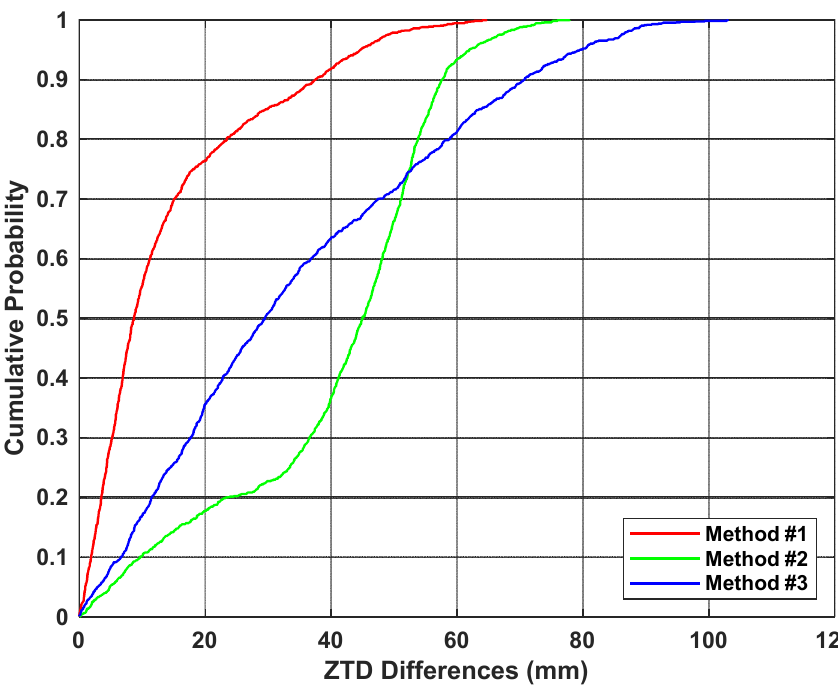
Figure 6. The empirical distribution functions of the ZTD differences for the three methods.